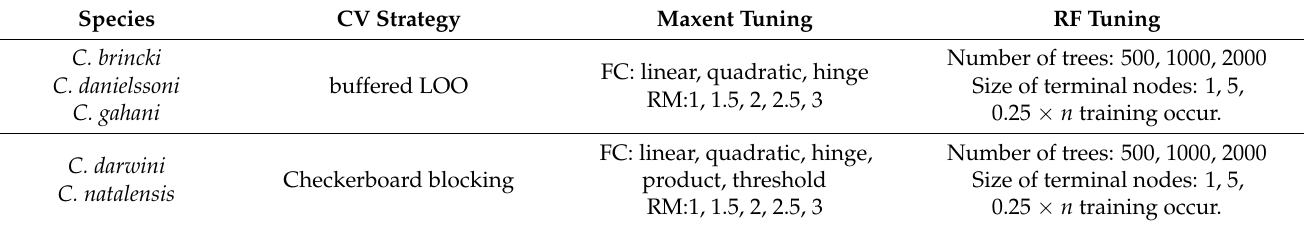
Table 2. Cross-validation strategy and tuning parameters used to fit and validate the ENMs for each target Chaetocnema